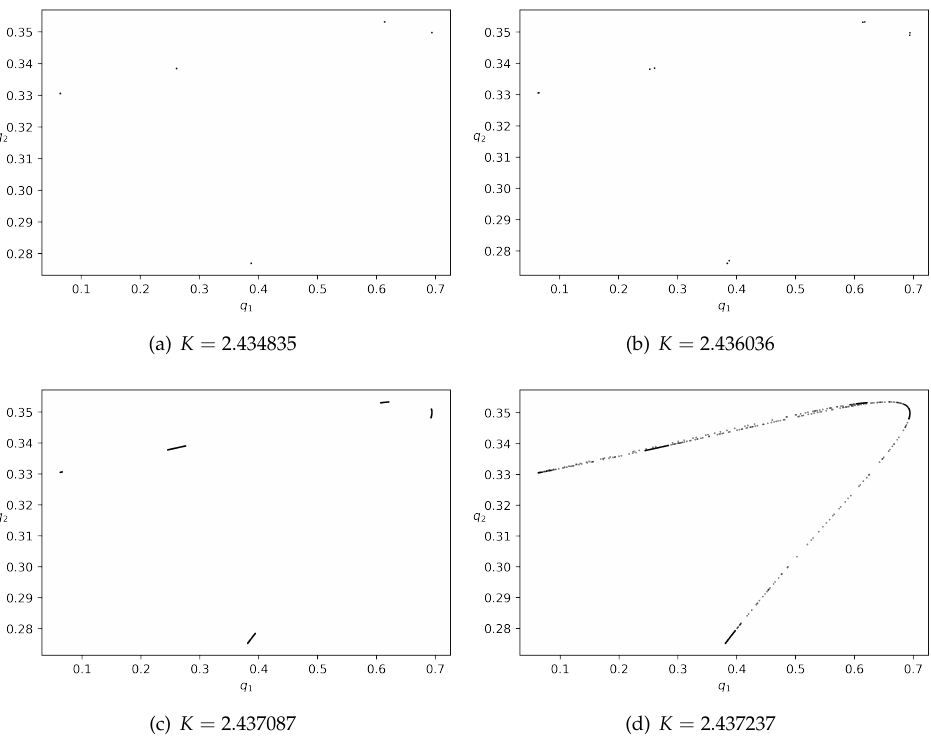
Figure 5. The phase portraits if fixing the parameters c 1 = 0.5, c 2 = 1.0 and setting the initial state as ( x ( 0 ) , y ( 0 )) = ( 0.5,0.5 )